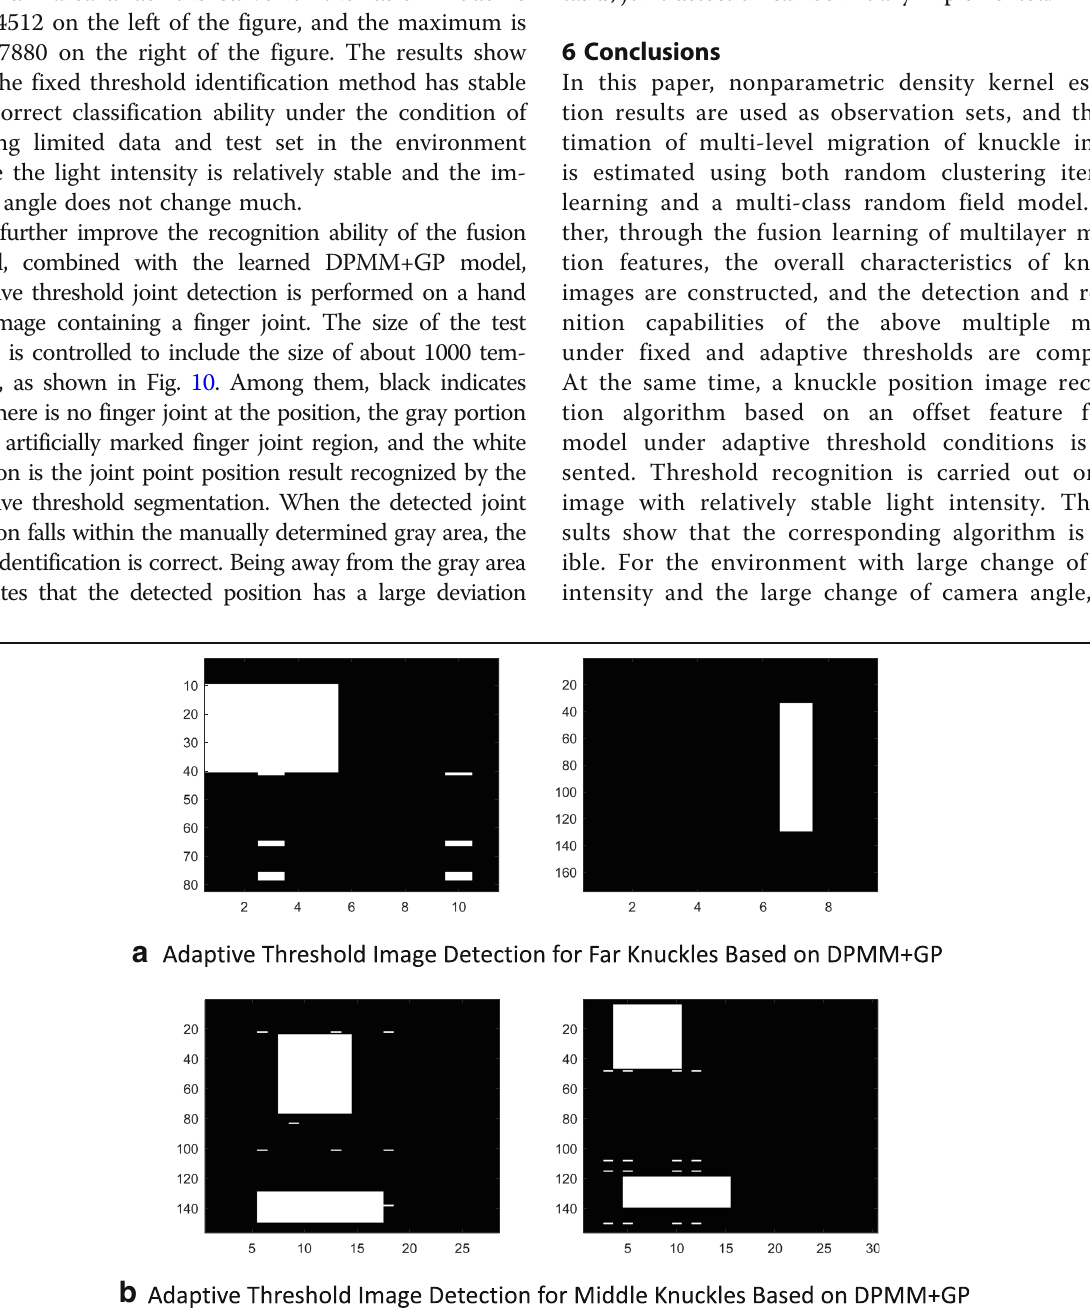
Fig. 10 Adaptive threshold image detection for knuckles. a Adaptive threshold image detection for far knuckles based on DPMM+GP. b Adaptive threshold image detection for middle knuckles based on